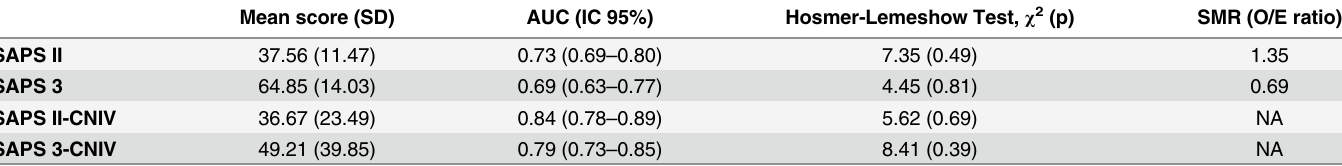
Table 3. Performance of the